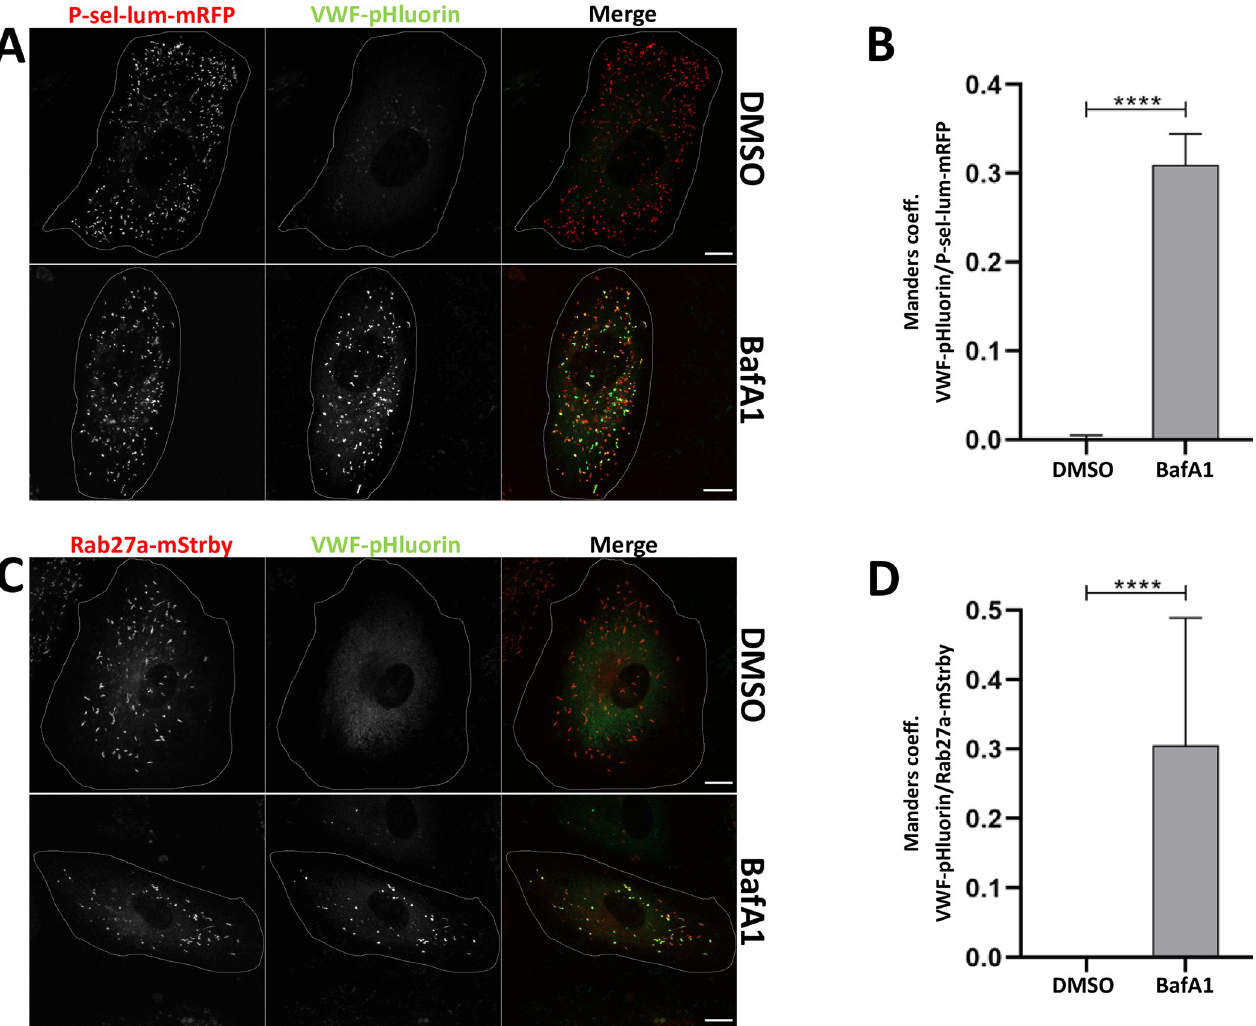
Fig 2. Acidification of WPB is inhibited by bafilomycin A1. A. Colocalization of P-sel-lum-mRFP and VWF-pHluorin fluorescence signals in HUVEC treated with the V-ATPase-specific inhibitor bafilomycin A1. HUVEC cotransfected with P-sel-lum-mRFP and VWF-pHluorin were incubated with 0.1% DMSO (upper panel) or 250 nM BafA1 (lower panel), respectively, at 37˚C for 2 h and subsequently subjected to live cell imaging. Shown are images of maximum intensity projections of z-stacks. Cell circumferences are indicated by lines. Scale bars: 10 μ m. B. The degree of colocalization of the fluorescence signals was quantified by determining Manders coefficient 1 which corresponds to the fraction of P-sel-lum-mRFP overlapping with VWF-pHluorin. n = 30. Bars indicate the median. Error bars show 95% confidence interval. Statistics were conducted using a Mann-Whitney test. ���� p � 0.0001, ��� p � 0.001, �� p � 0.01, � p � 0.05. C. Rab27a-positive WPB are affected by bafilomycin A1 treatment. Cells expressing Rab27a-mStrawberry and VWF-pHluorin were incubated with 0.1% DMSO (upper panel) or 250 nM BafA1 (lower panel), respectively, at 37˚C for 2 h and subsequently analyzed via live cell imaging. Shown are images of maximum intensity projections of z-stacks. Cell circumferences are indicated by lines. Scale bars: 10 μ m. D. The extent of colocalization of the fluorescence signals was quantified by determining Manders coefficient 1 which corresponds to the fraction of Rab27a-mStrawberry overlapping with VWF- pHluorin. n = 10. Bars indicate the median. Error bars show 95% confidence interval. Statistics were conducted using a Mann-Whitney test. ���� p � 0.0001, ��� p � 0.001, �� p � 0.01, � p � 0.05.